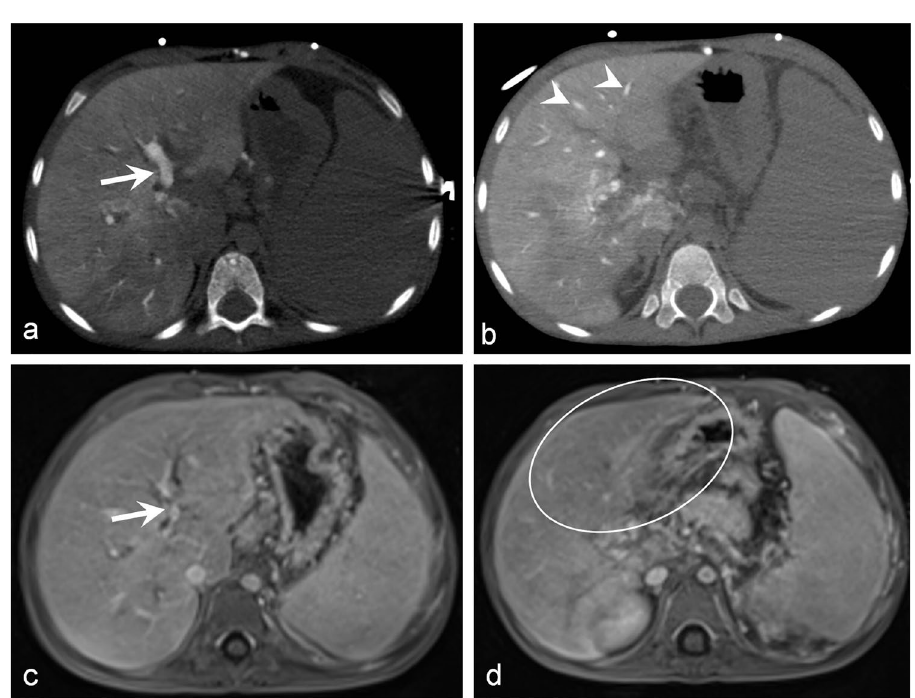
Figure 3. A 6-year-old male patient with EHPVO. Axial images of CT-AP ( a , b ) and CE-MR ( c , d ). The left central (arrows) and peripheral PV (arrowheads) were not confidently assessed in CE-MR, especially for the peripheral left PV CE-MR was non-diagnostic (circle in d